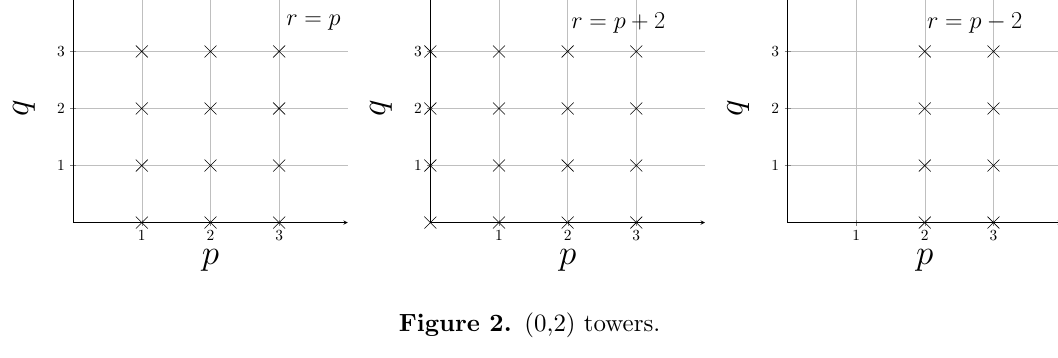
Figure 2. (0,2) towers.